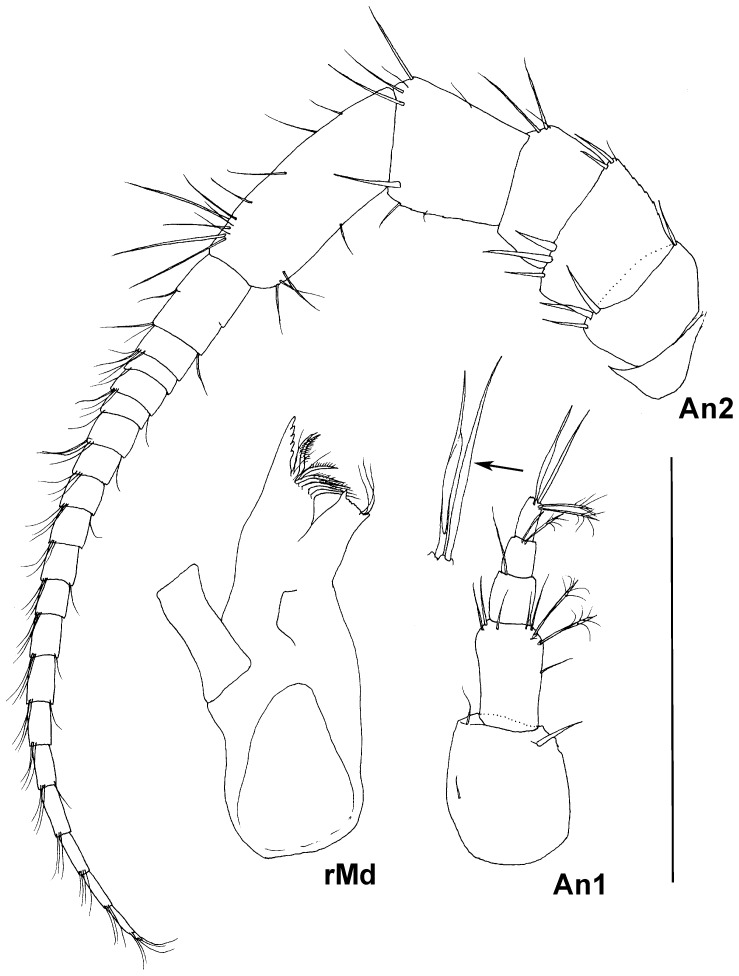
Paratype ZMH K-44090, male, antennula and right mandible, scale – 0.5 mm.